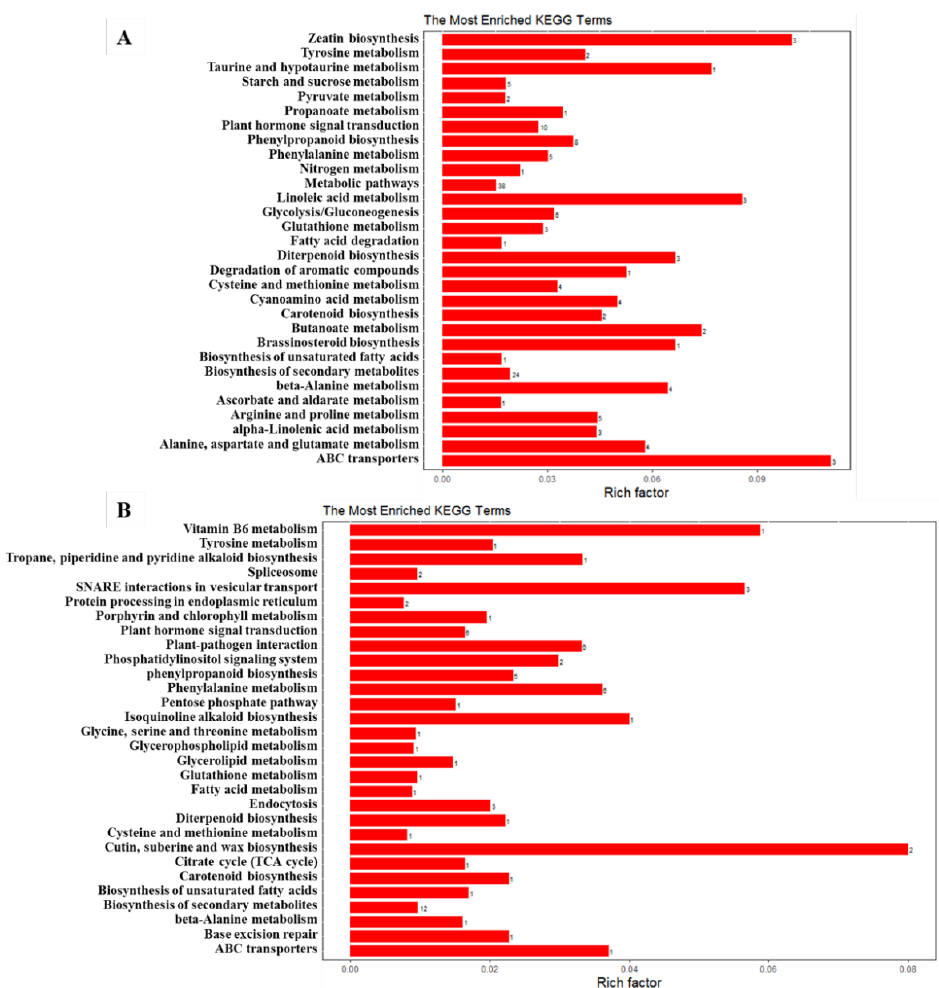
Figure 16. KEGG pathway analysis of DEGs. ( A ) KEGG pathway analysis of significantly up-regulated genes. ( B ) KEGG pathway analysis of significantly down-regulated genes.